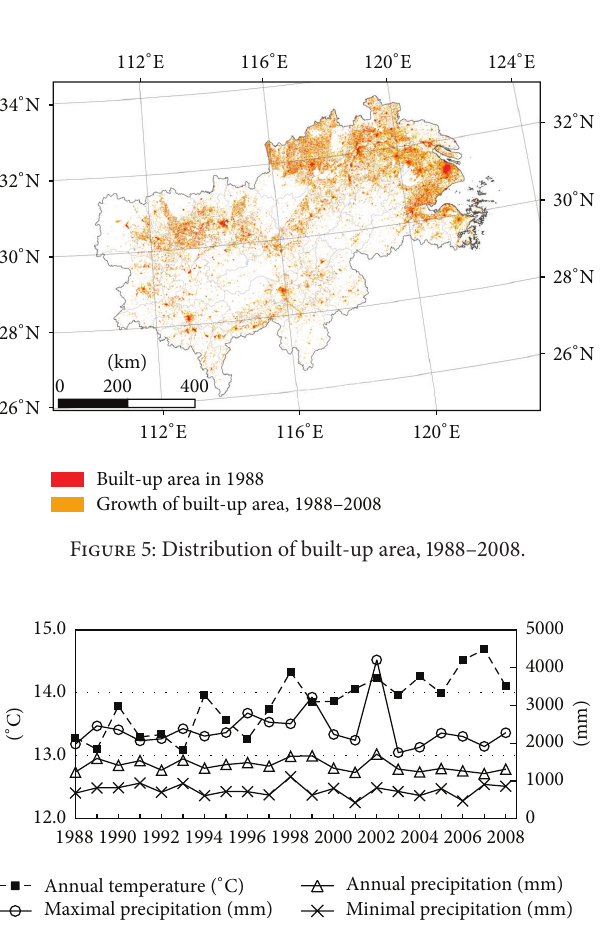
Figure 6: Temporal changes of temperature and precipitation in the study area,